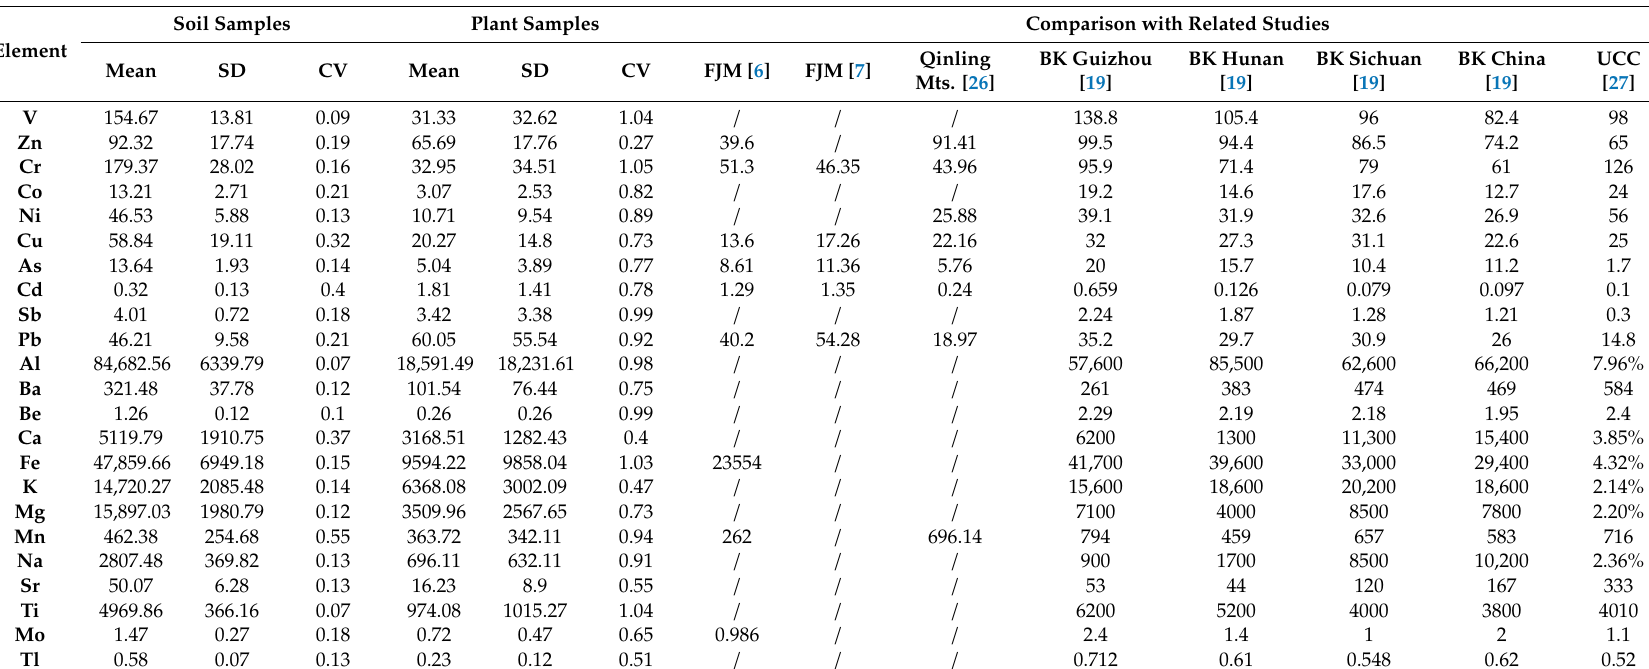
Table 3. The descriptive statistical analysis of 23 element contents (mg · kg − 1 ) in the Jiulongchi wetland and the comparison with related studies.